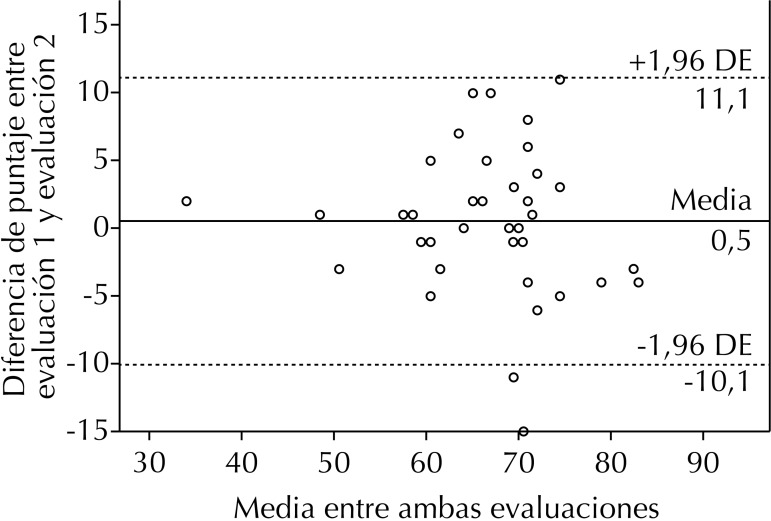
Bland-Altman inter-evaluador. Comparación de los puntajes obtenidos al evaluar en dos oportunidades un mismo video. Santiago de Chile, 2013. (N = 38)